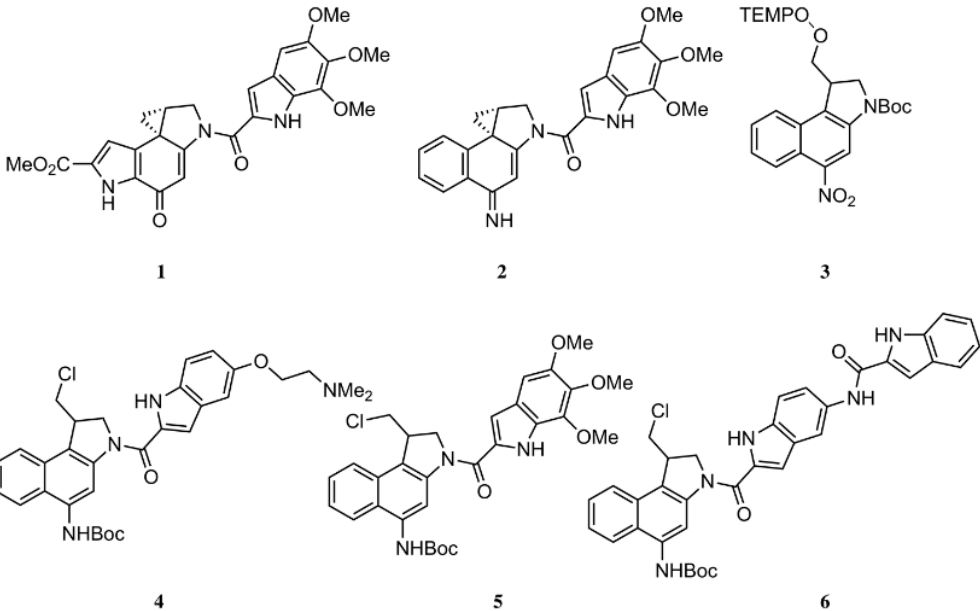
Figure 1. Structures of Duocarmycin SA, 1 , amino-CBI, 2 , Key intermediate, 3 , final seco -amino-CBIs, 4 – 6 .